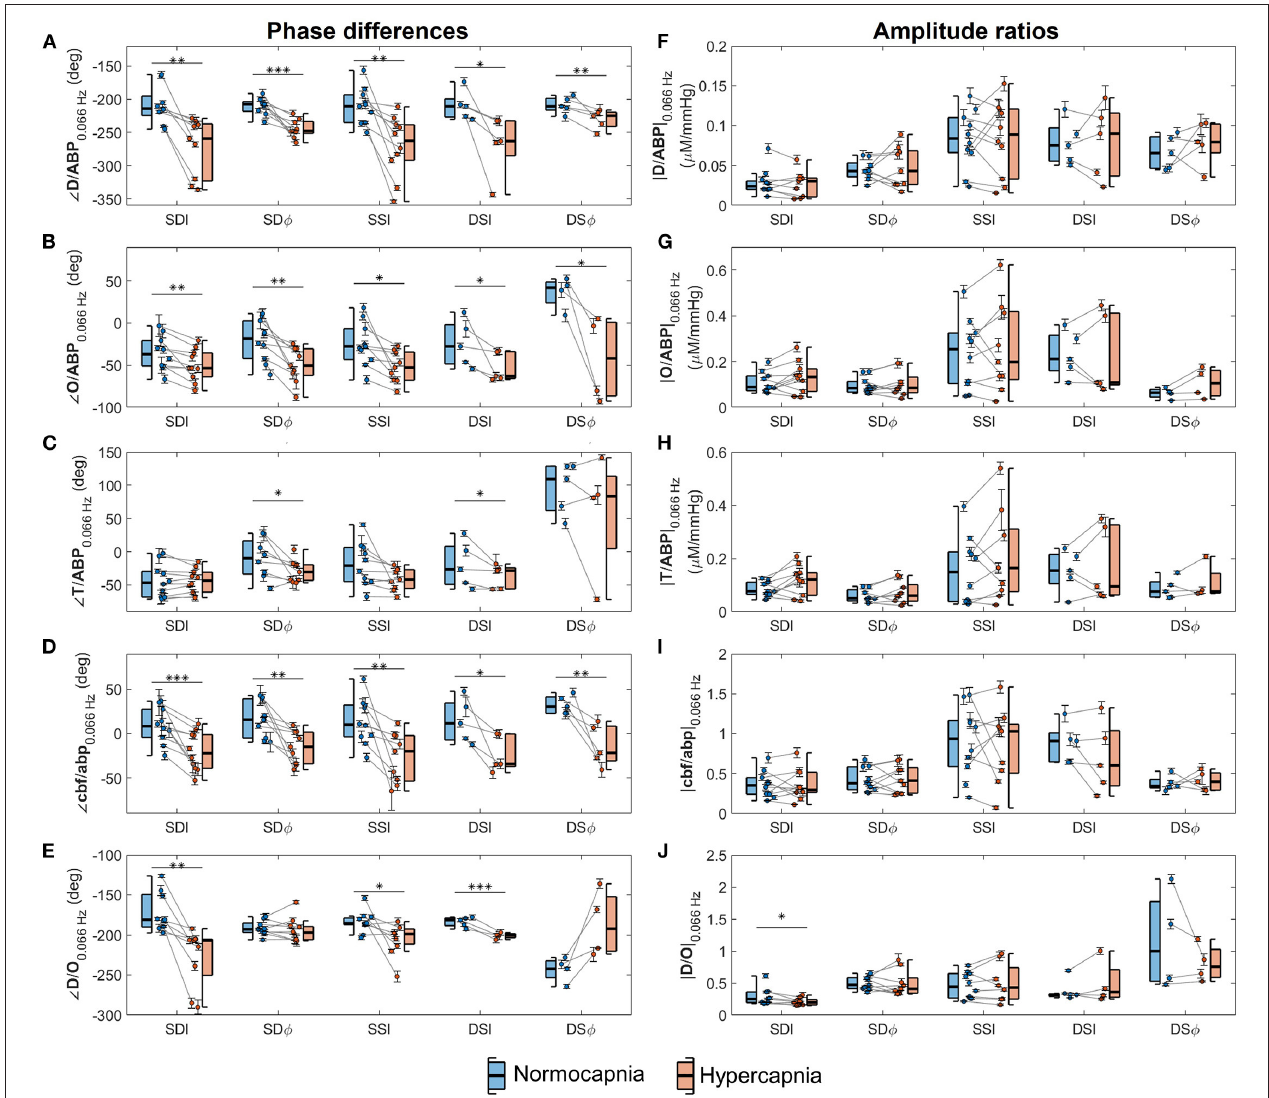
FIGURE 3 | Box plots depicting average phase differences ( left column) and amplitude ratios ( right column) of phasors of deoxyhemoglobin ( D ) vs. phasors of arterial blood pressure ( ABP ) (panels A,F ), oxyhemoglobin ( O ) vs. ABP (panels B,G ), total hemoglobin ( T ) vs. ABP (panels C,H ), normalized cerebral blood flow ( cbf ) vs. normalized arterial blood pressure ( abp ) (panels D,I ), and D vs. O (panels E,J ) at 0.066 Hz. Boxes are shown for normocapnia ( blue ) and hypercapnia ( red ). On each box, the central line is the median, the edges are the 25 and 75% quartiles, and the whiskers indicate the most extreme data points excluding outliers. Circles indicate individual measurements, and error bars represent the standard errors of the measurements. Each gray line connects normocapnic and hypercapnic data points from the same measurement session. Horizontal lines ( black ) indicate comparison between normocapnia and hypercapnia by means of statistical tests and corresponding p -values are denoted ( ∗ p < 0.05; ∗∗ p < 0.01; ∗∗∗ p <